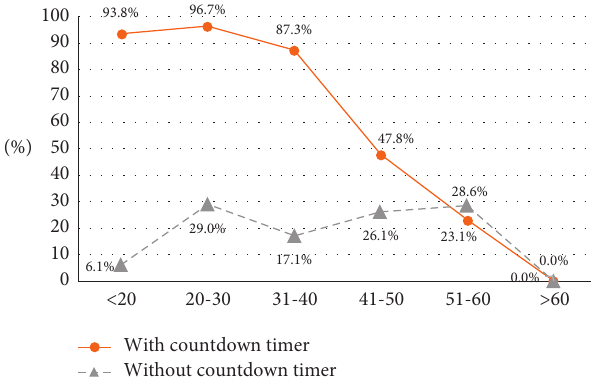
Figure 2: Percentage of the start of roadway crossing during the clearance time by the age, for both types of